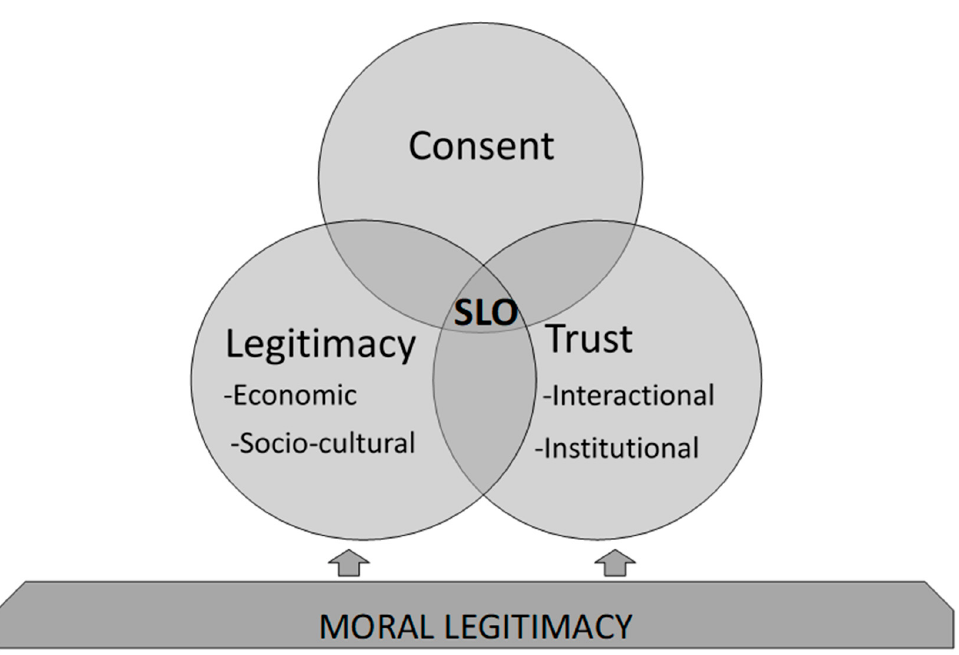
Figure 2. Model representing the academic consensus on factors influencing the development of a social license to operate